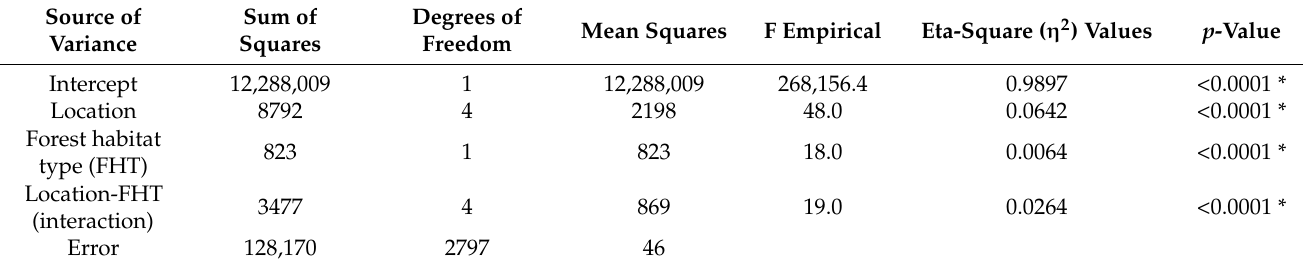
Table 5. Effect on wood hardness of location and habitat type and interaction between these factors (two-way analysis of